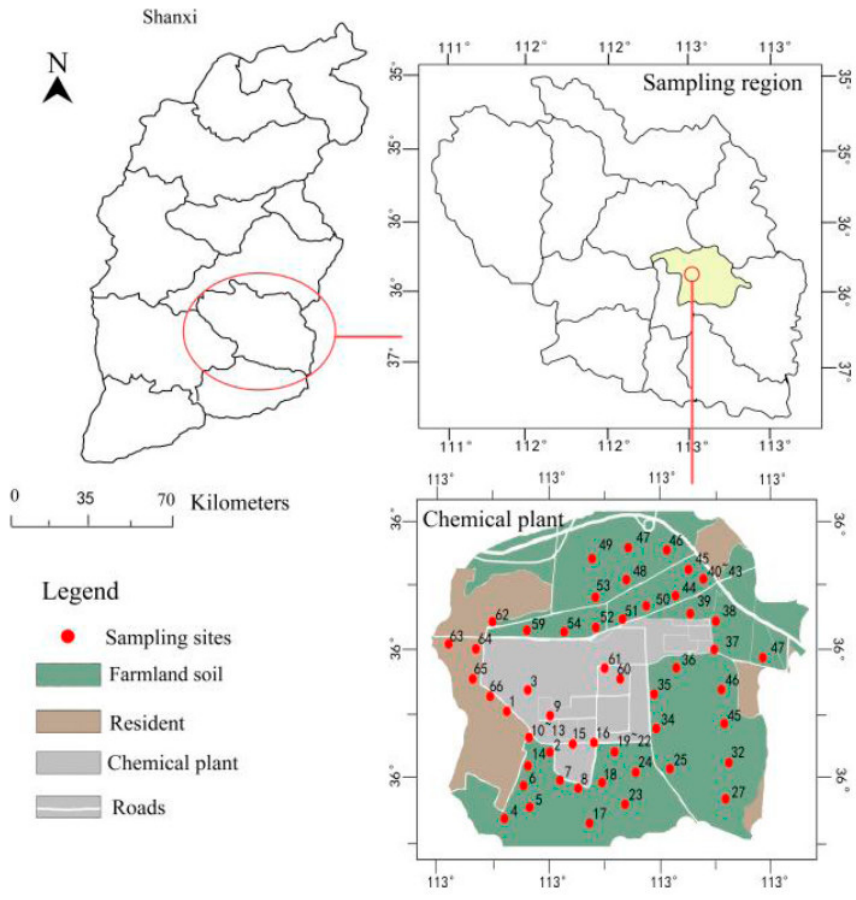
Figure1. A map showing the sampling area and sites. Figure 1. A map showing the sampling area and